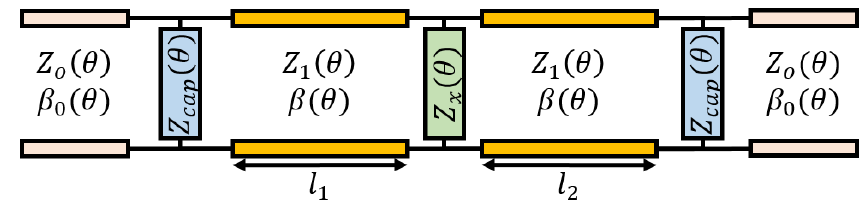
Figure 2. EC of a generic loaded unit-cell with θ dependence.